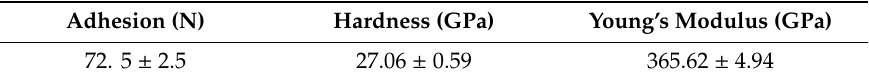
Table 4. Mechanical test results of the coating.